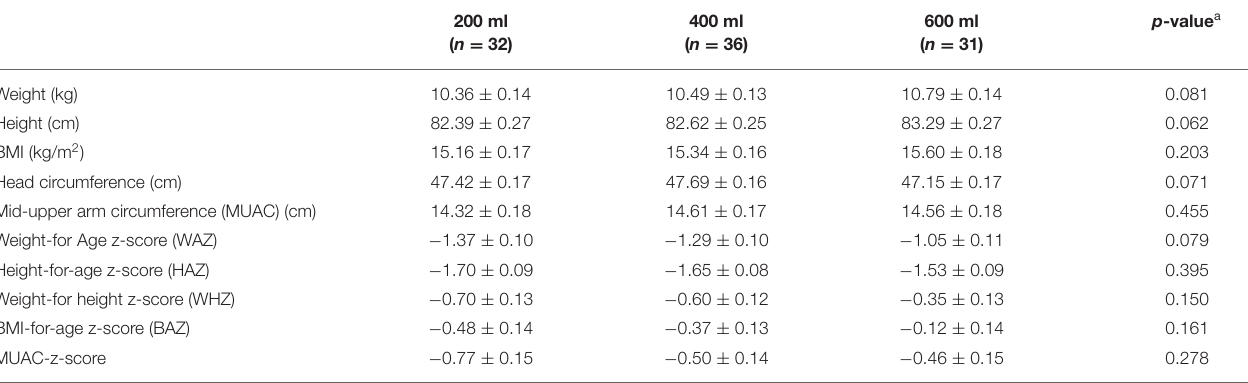
TABLE 5 | Endline anthropometric data of the modified PP population of Nigerian toddlers with malnutrition who were provided with a fortified dairy-based drink in daily amounts of 200, 400 or 600ml, during 6 months (data presented as means ±